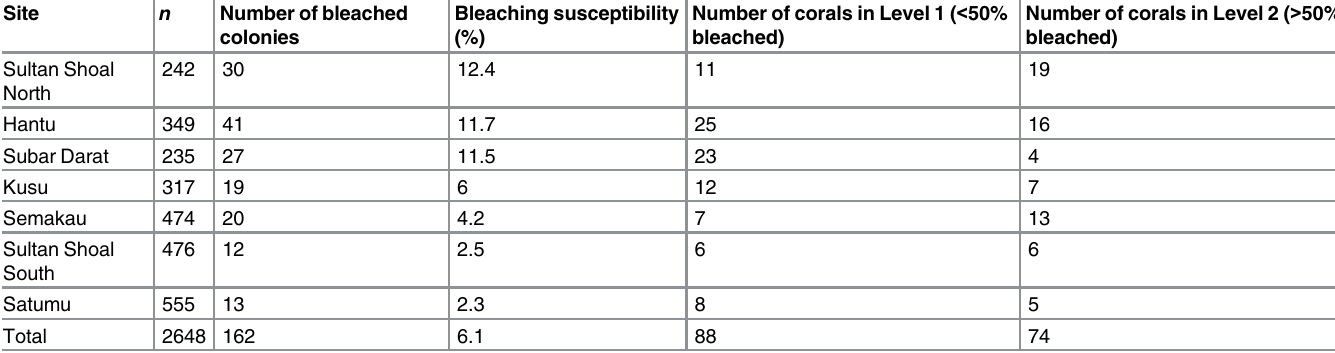
Table 2. Bleaching response of coral colonies from seven study sites during a minor bleaching episode in Singapore in 2013. Site n Number of bleached Bleaching susceptibility Number of corals in Level 1 ( < 50% colonies (%) bleached)